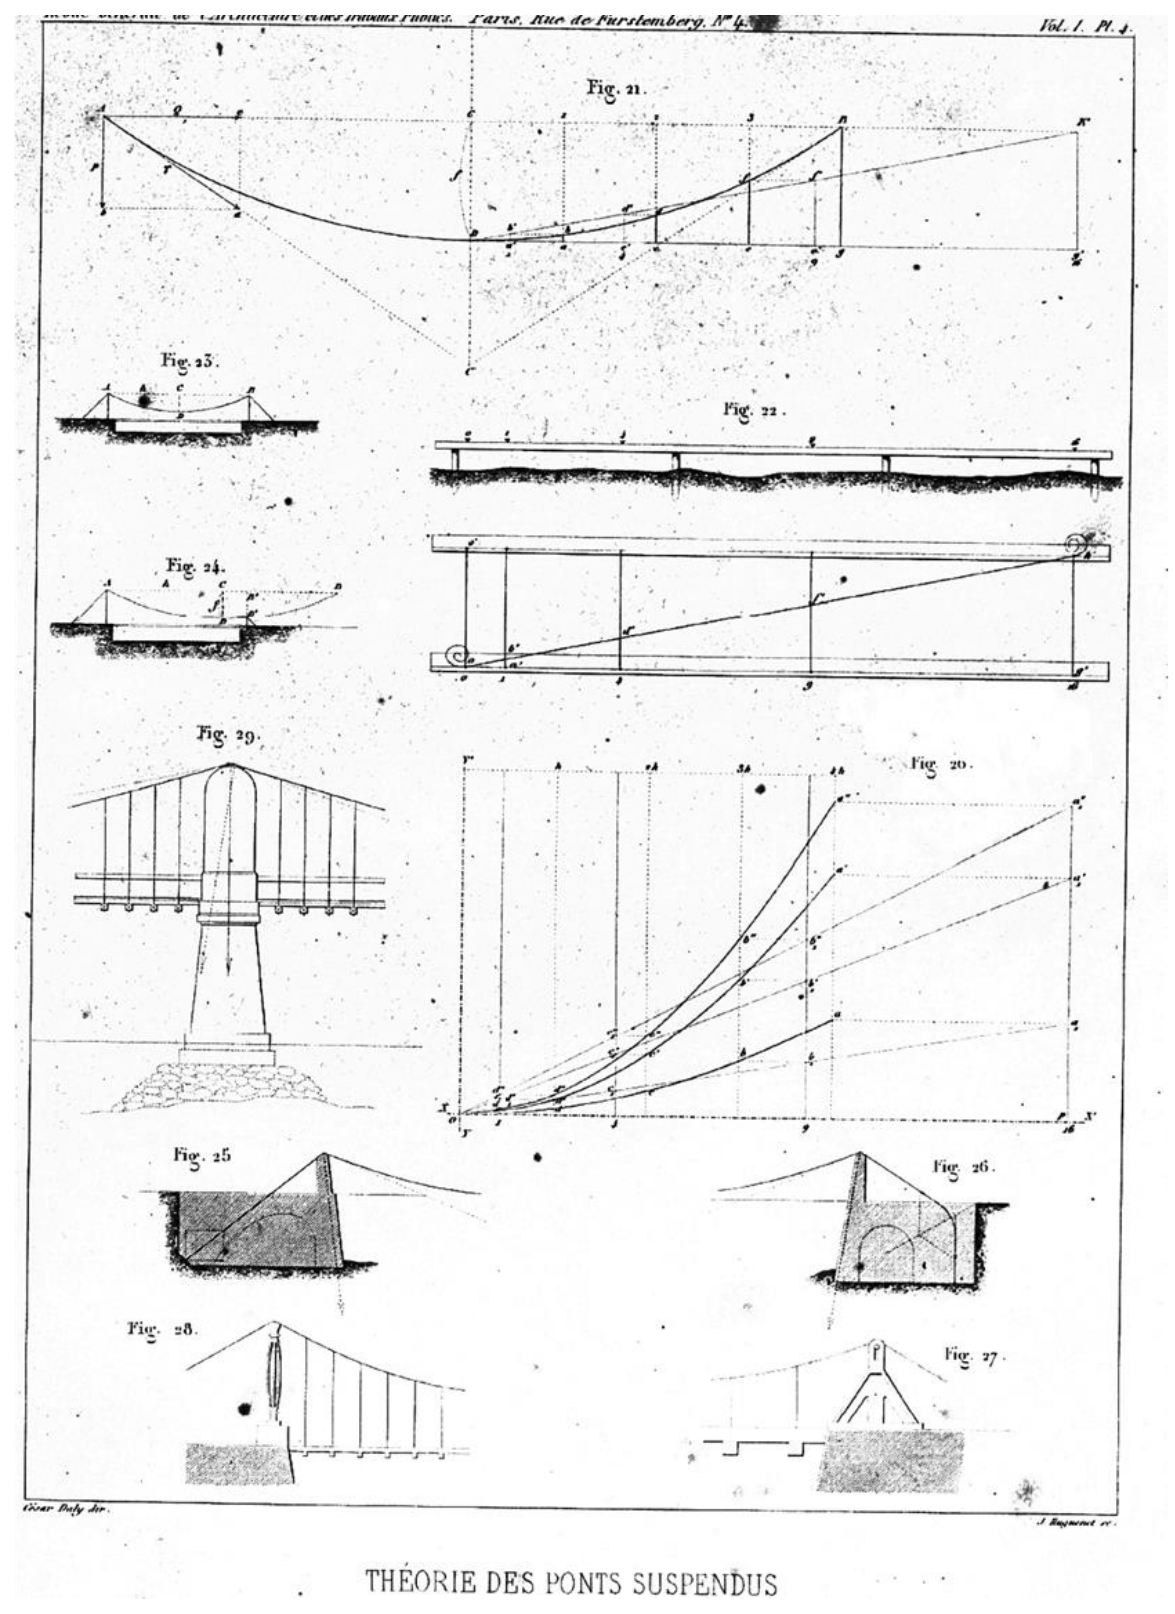
Figure 15. Graphical extract from the article suspension bridge theory. Source: “Revue Générale et des Travaux Publics”, 1840. Vol.1, (Pl.4). Edited by César Daly. Reference [36].